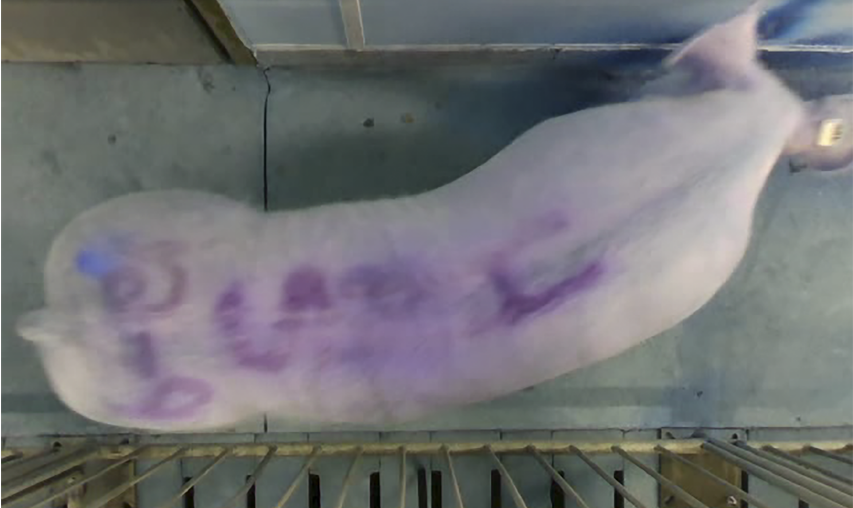
Figure 2. Painted numbers and ear tag for optical character recognition on a sow.